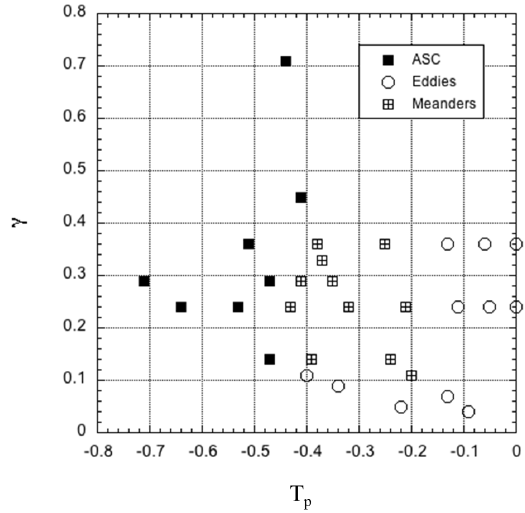
Figure 9. Diagram in the (cid:0) T p , γ (cid:1) parameter space of the various instability regimes: coastal eddies (open circle), coastal meanders (square with cross), and the quasi-stable along-slope current (filled